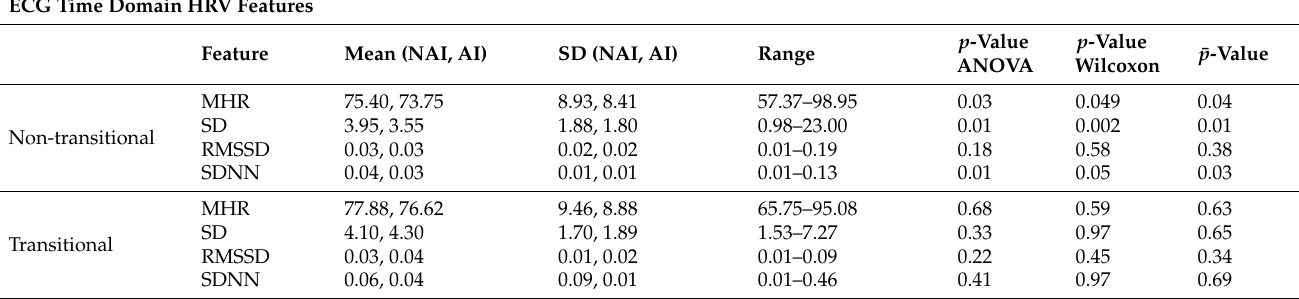
Table 2. ECG time domain HRV features. Mean heart rate: MHR; standard deviation (SD) of heart rate; root mean square of successive differences: RMSSD; standard deviation of NN intervals: SDNN; non-anxiety-induced (NAI); anxiety-induced (AI).